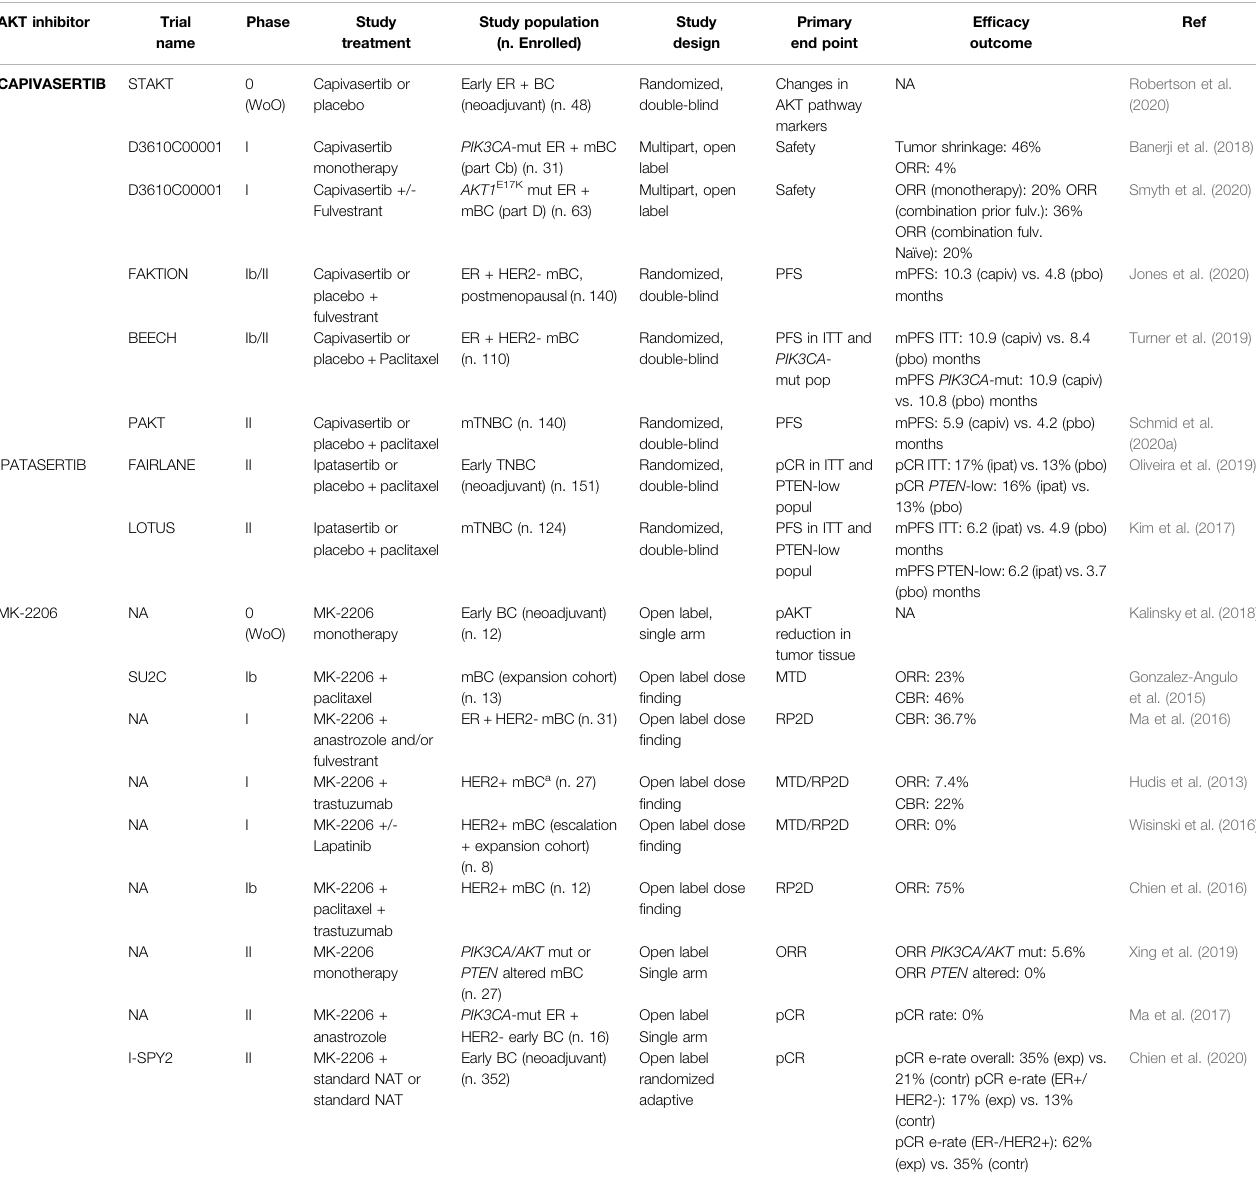
TABLE 2 | Published trials of AKT inhibitors in breast cancer. AKT